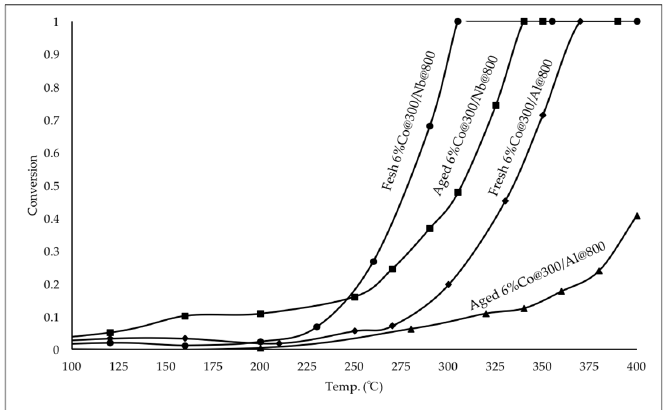
Figure 6. Fresh and aged 6% Co@300/Nb@800 and 6% Co@300/Al@800 for propane oxidation with moisture. Aging test was conducted at 400°C with reaction gases for 12 h. Gas composition with H 2 O 5 vol %, C 3 H 8 0.1 vol %, O 2 17.85 vol %, N 2 77.05 vol %. Catalysis volume: 0.1 mL, GHSV: 64,800 (h − 1 ).